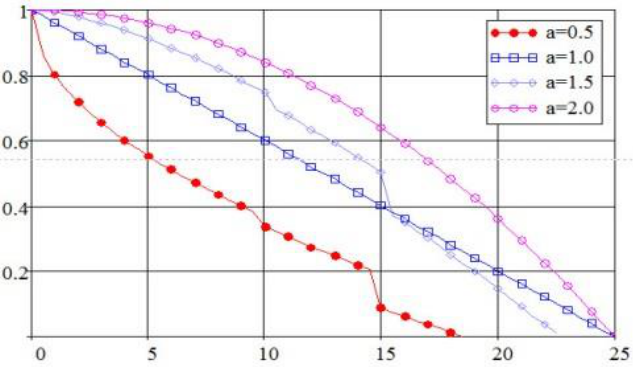
Figure 7. Functions of resistance to refusal by formation of defects and their partial